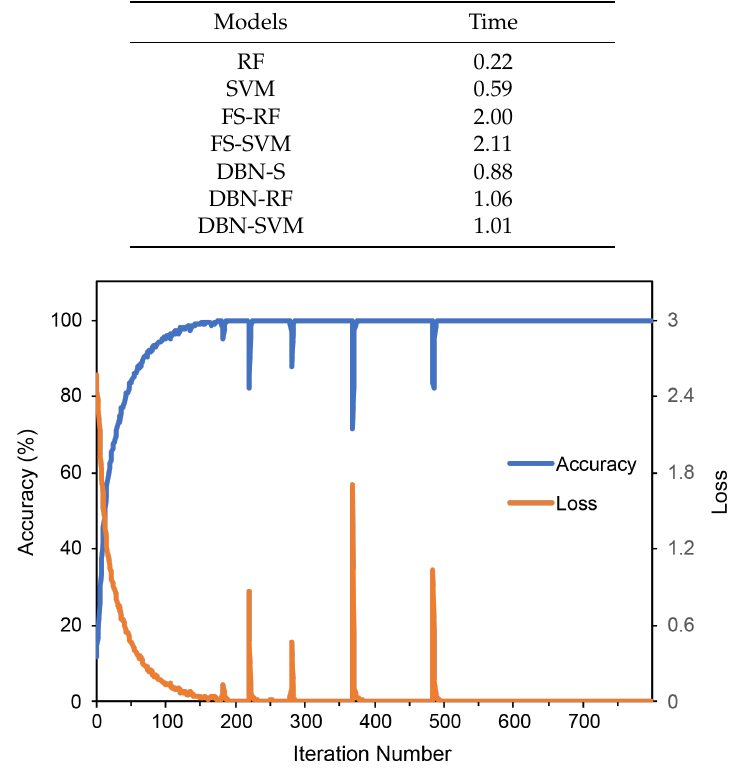
Table 6. The time (hour) for each model.